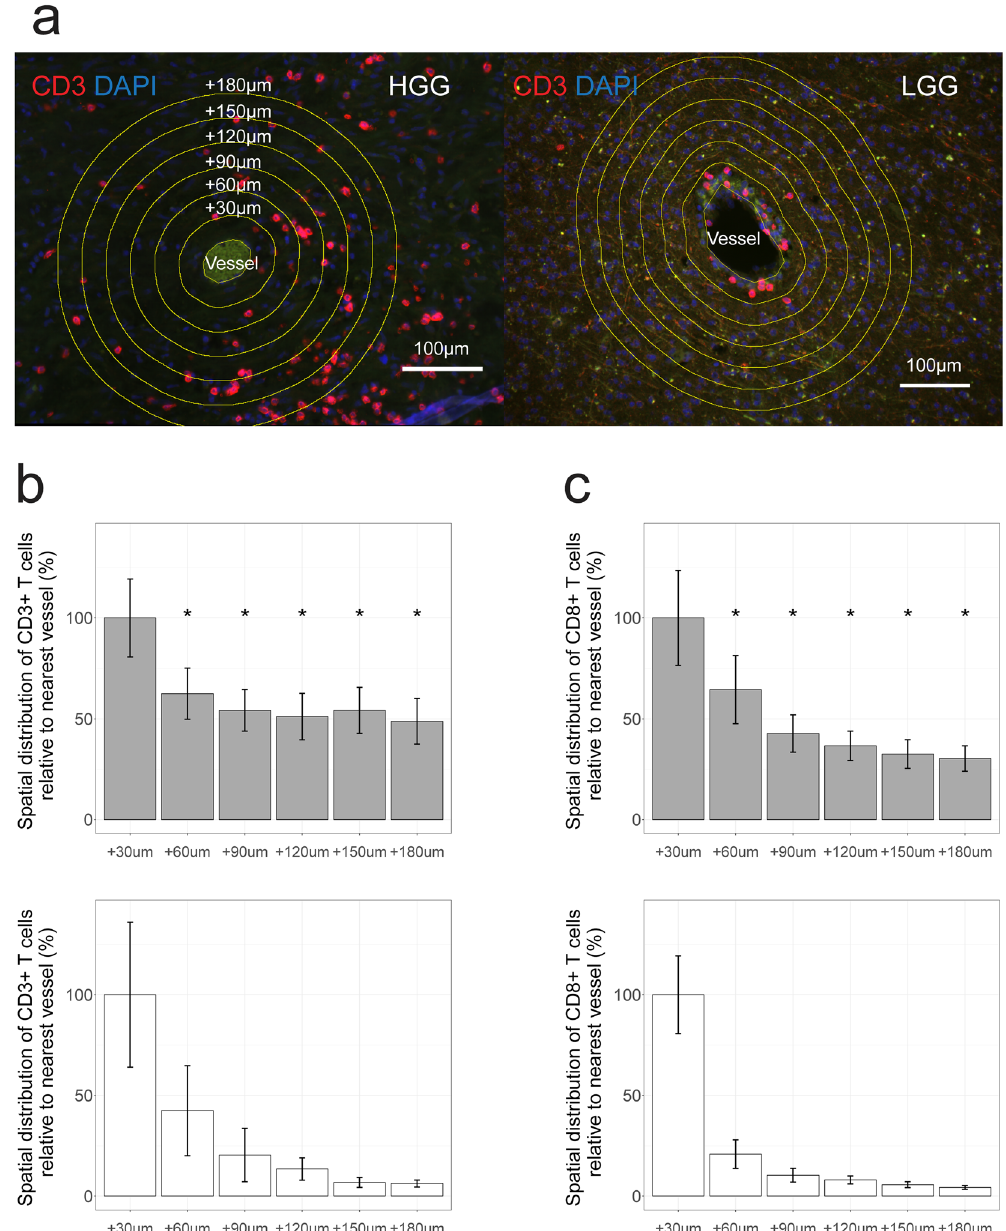
Figure 2. T cells are retained to blood vessels in LGG compared to HGG. Spatial distribution of T cells in HGG (n = 28) and LGG (n = 28) was determined by CD3 and CD8 immune stainings. ( a ) T cells were quantified in consecutive perimeters of 30 µ m (30–180 µ m) starting from the border of vessels from different tumor regions (left panel; representative HGG example, right panel; representative LGG example, stained for CD3). Vessels were identified using autofluorescence and are positive for CD31 (see also Fig. S2). Magnification is 20 × . Scale bar is 100 µ m. ( b ) Spatial distribution of CD3 and ( c ) CD8 T cells in HGG (top) vs LGG (bottom). Mean number of T cells within first perimeter is set at 100%. Values for each perimeter are compared between HGG and LGG, Mann-Whitney U test. * P <